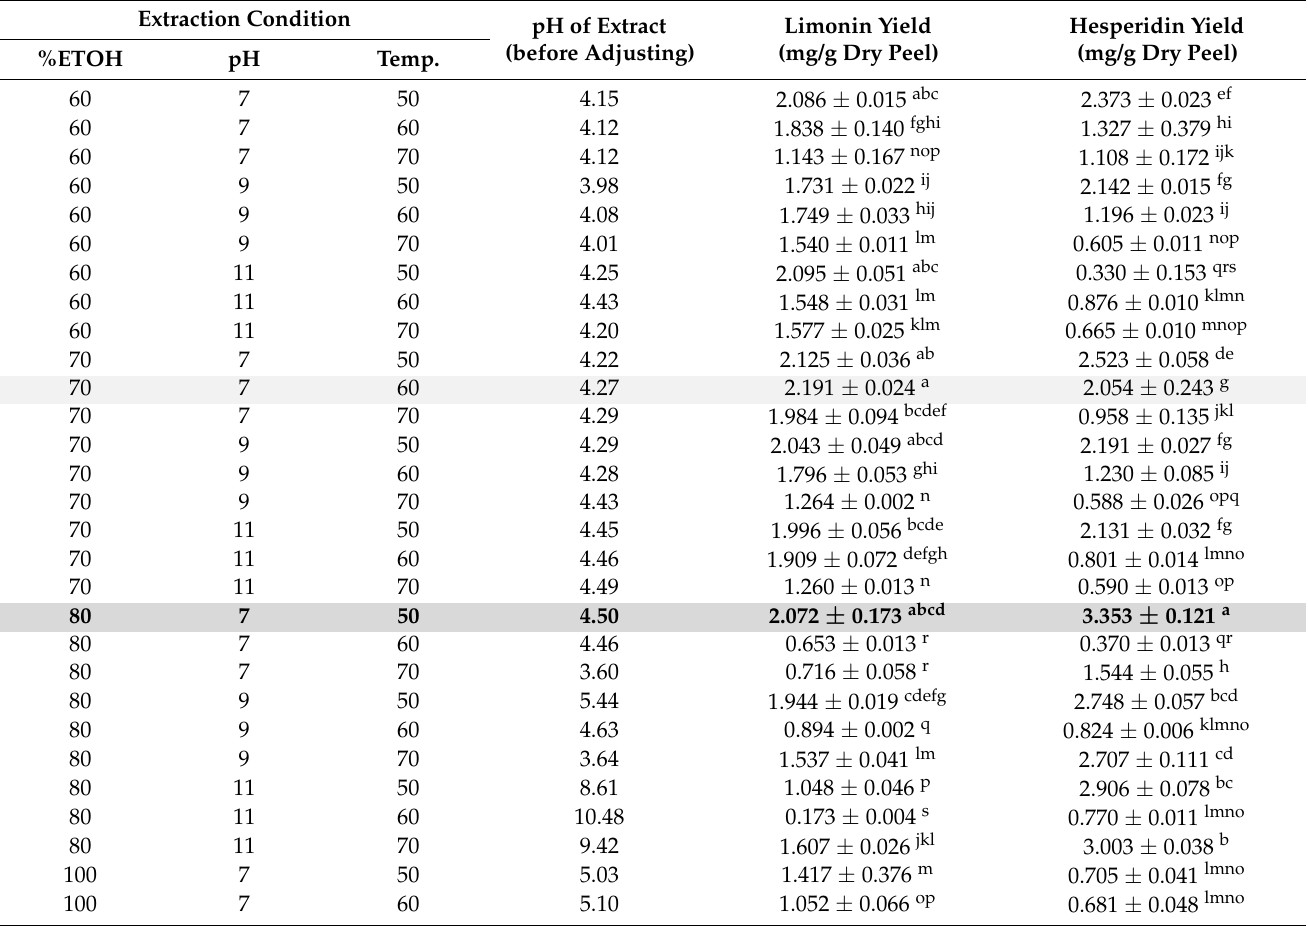
Figure 3. Effect of temperature on extraction efficiency. Limonin ( A ) and hesperidin ( B ) concentrations in the ethanolic-aqueous extracts of lime peel after extraction with 60% ( ● ), 70% ( ■ ), 80% ( ▲ ), and 100% ( ▼ ) ethanol in water with the specified temperatures, at pH 7 for 100 min. The statistical differences were separately analyzed for limonin and hesperidin by using one-way ANOVA followed by Tukey’s multiple comparisons test. * , **, *** and **** mean p < 0.05, < 0.01, < 0.001 and < 0.0001, respectively, compared with the concentrations of limonin or hesperidin at 50 °C of each specified condition. Table 1. Yields of limonin and hesperidin in lime peel ethanolic-aqueous extracts; each extraction condition is at a solid-to-solvent ratio (SSR) of 0.01